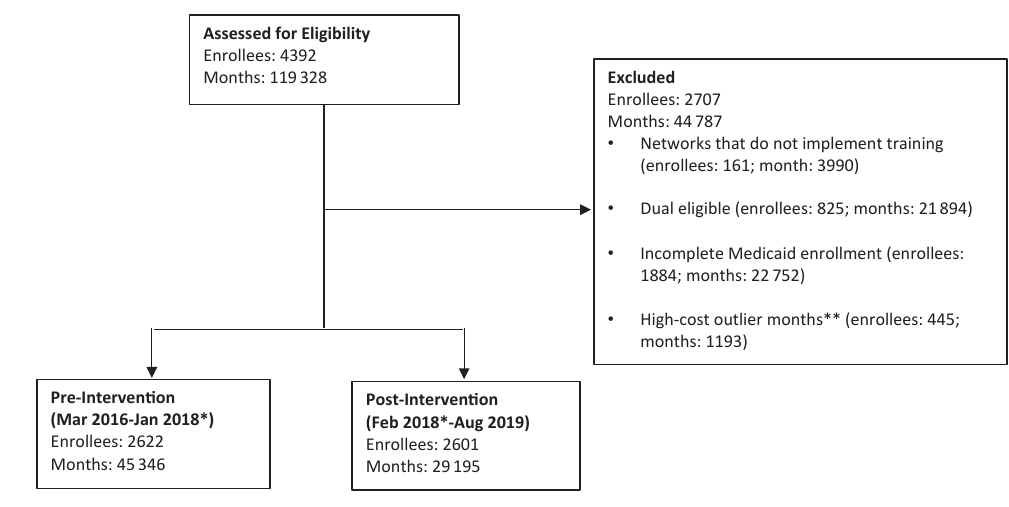
Figure 1. Sample Exclusions